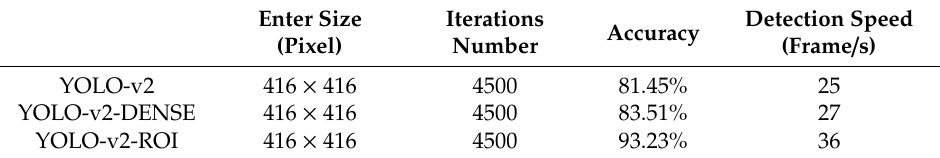
Table 3. Detection e ff ects of di ff erent algorithms.